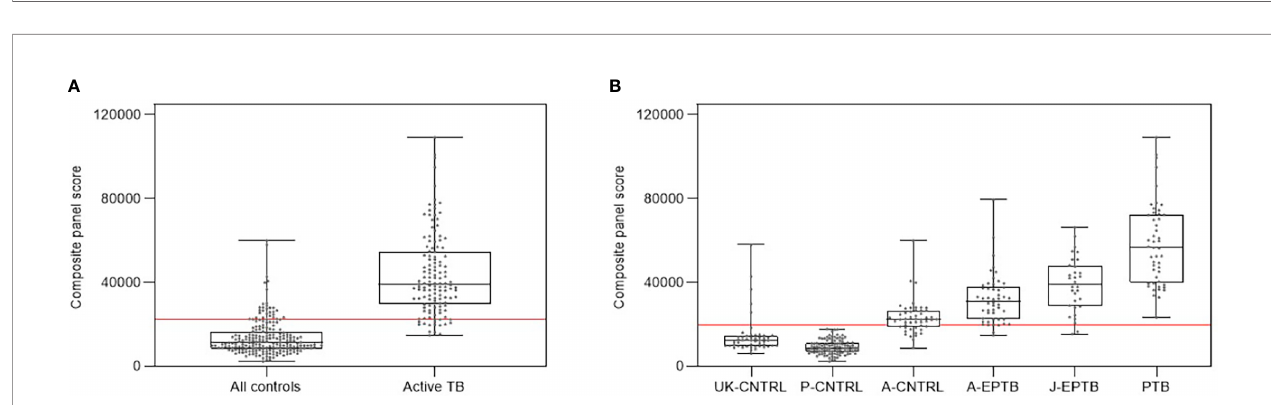
FIGURE 4 | (A) Variable Importance Plot of decrease in Gini scores as measured by Random Forest for (I) classi fi cation of All Controls, EPTB and PTB (II) Classi fi cation of All Controls and PTB . (B) ROC curves of composite panel scores generated from (I) the complex 6-plex panel for discrimination of individual TB groups and combined Active TB from All controls (II) the simple 3-plex panel for the discrimination of individual TB groups and combined Active TB from All controls. All controls vs A-EPTB ─── , all controls vs J-EPTB ─ ─ , all controls vs PTB ─ ─ ─ , all controls vs all combined active TB ─ ─ ─ ─ .